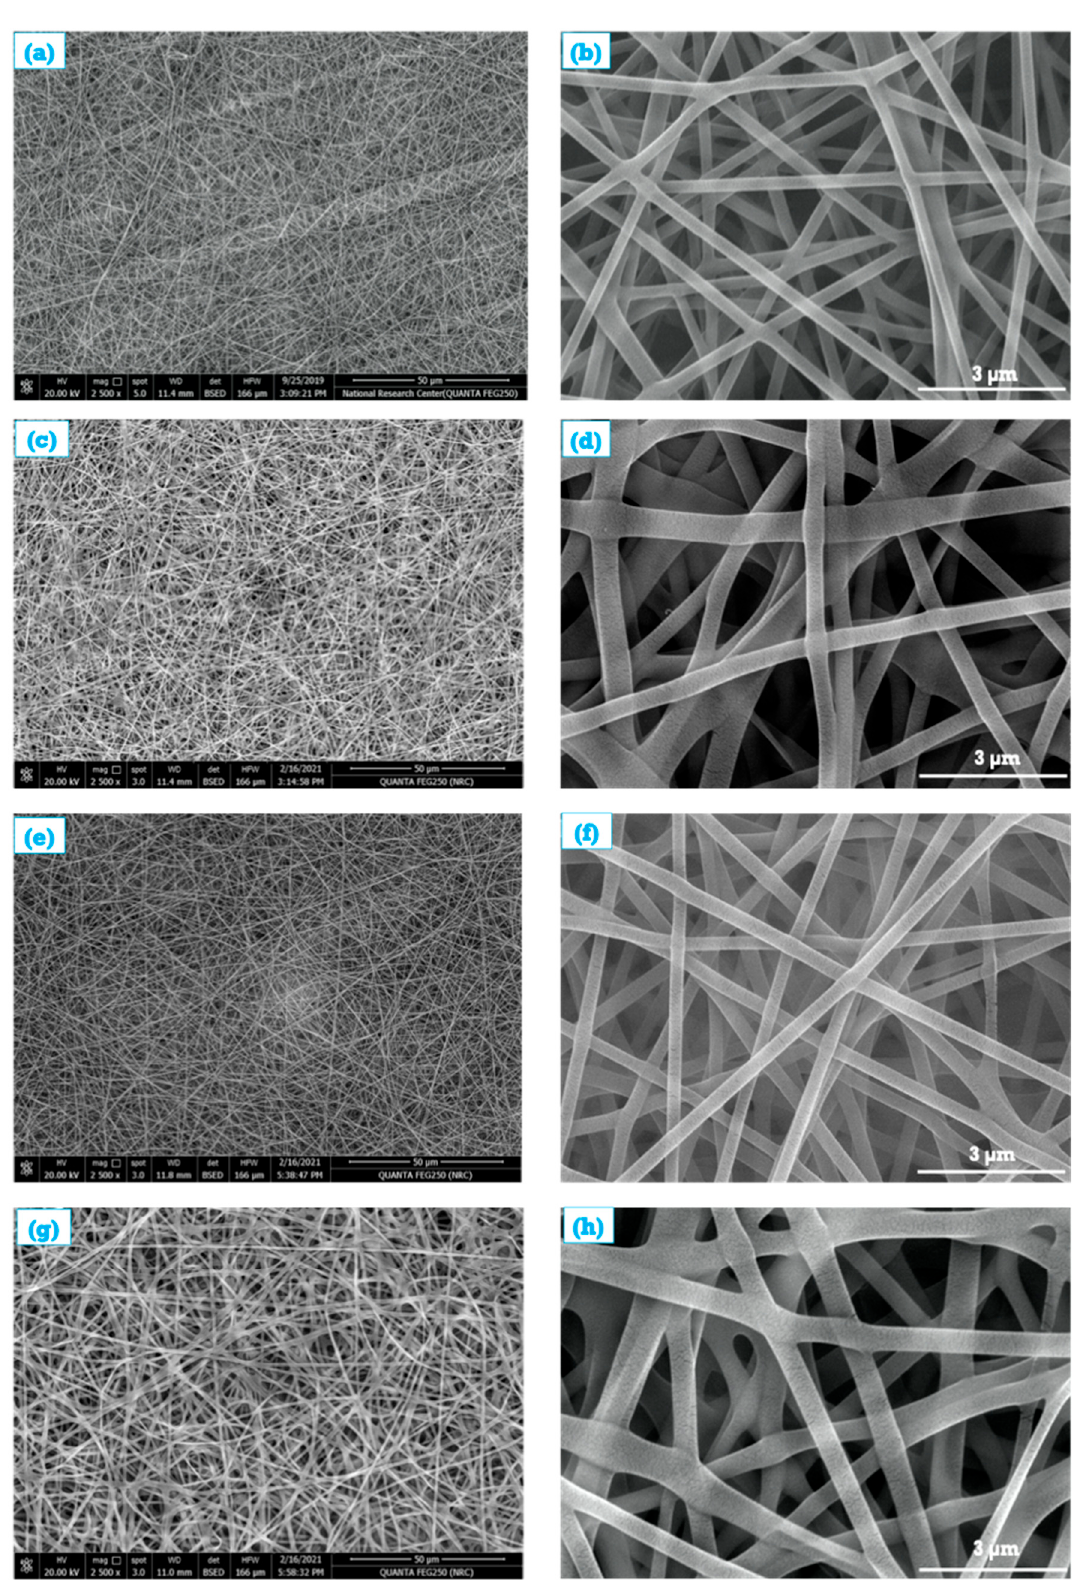
Figure 3. SEM images of ( a , b ) AgNPs-0@NFs, ( c , d ) AgNPs-1@NFs, ( e , f ) AgNPs-2@NFs and ( g , h )